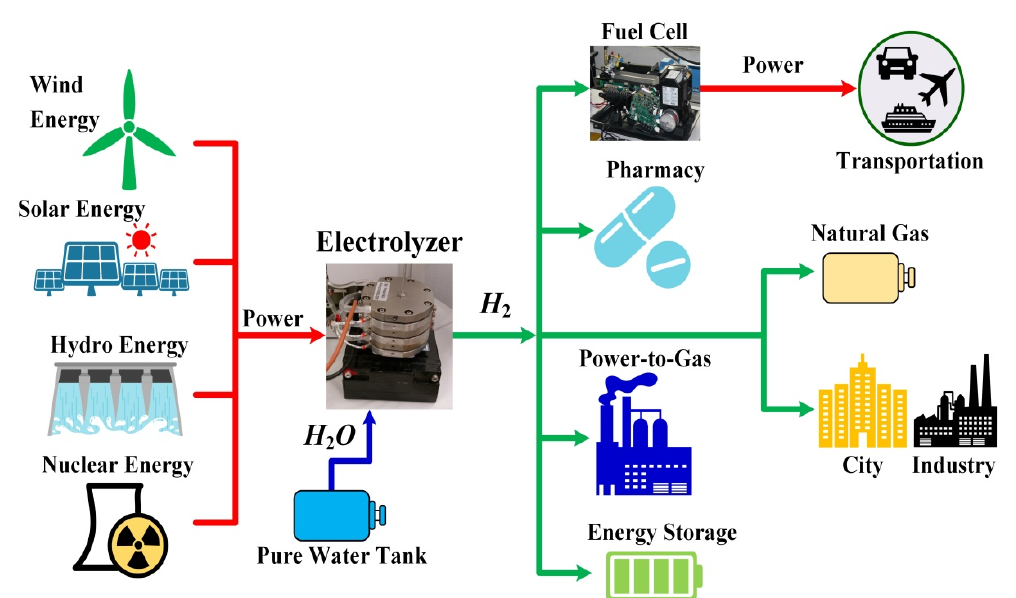
Figure 6. Overview of hydrogen applications considering renewable and nuclear power sources.